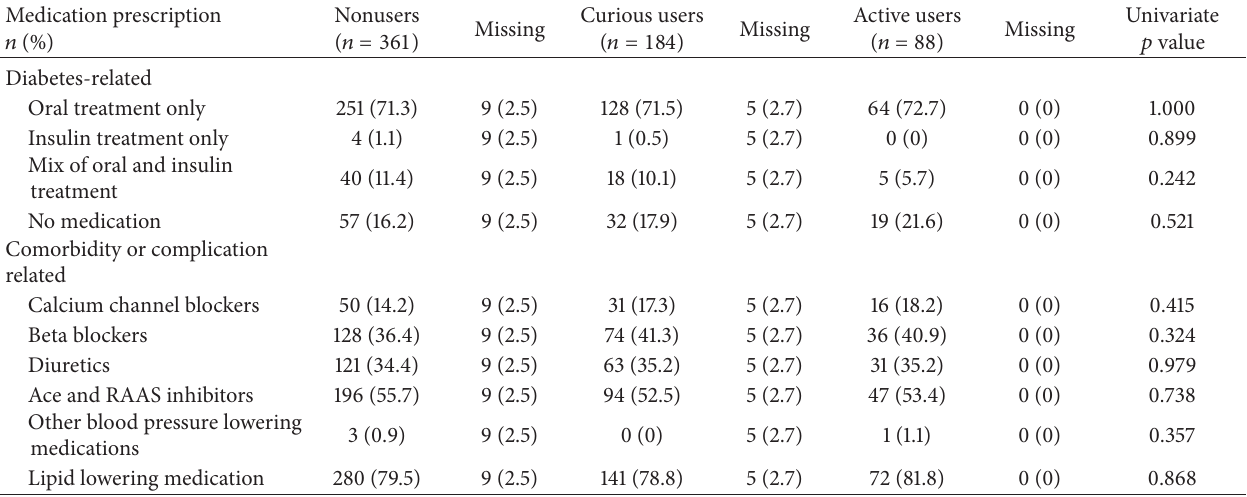
Table 10: Medication prescription of curious users, active users, and nonusers.